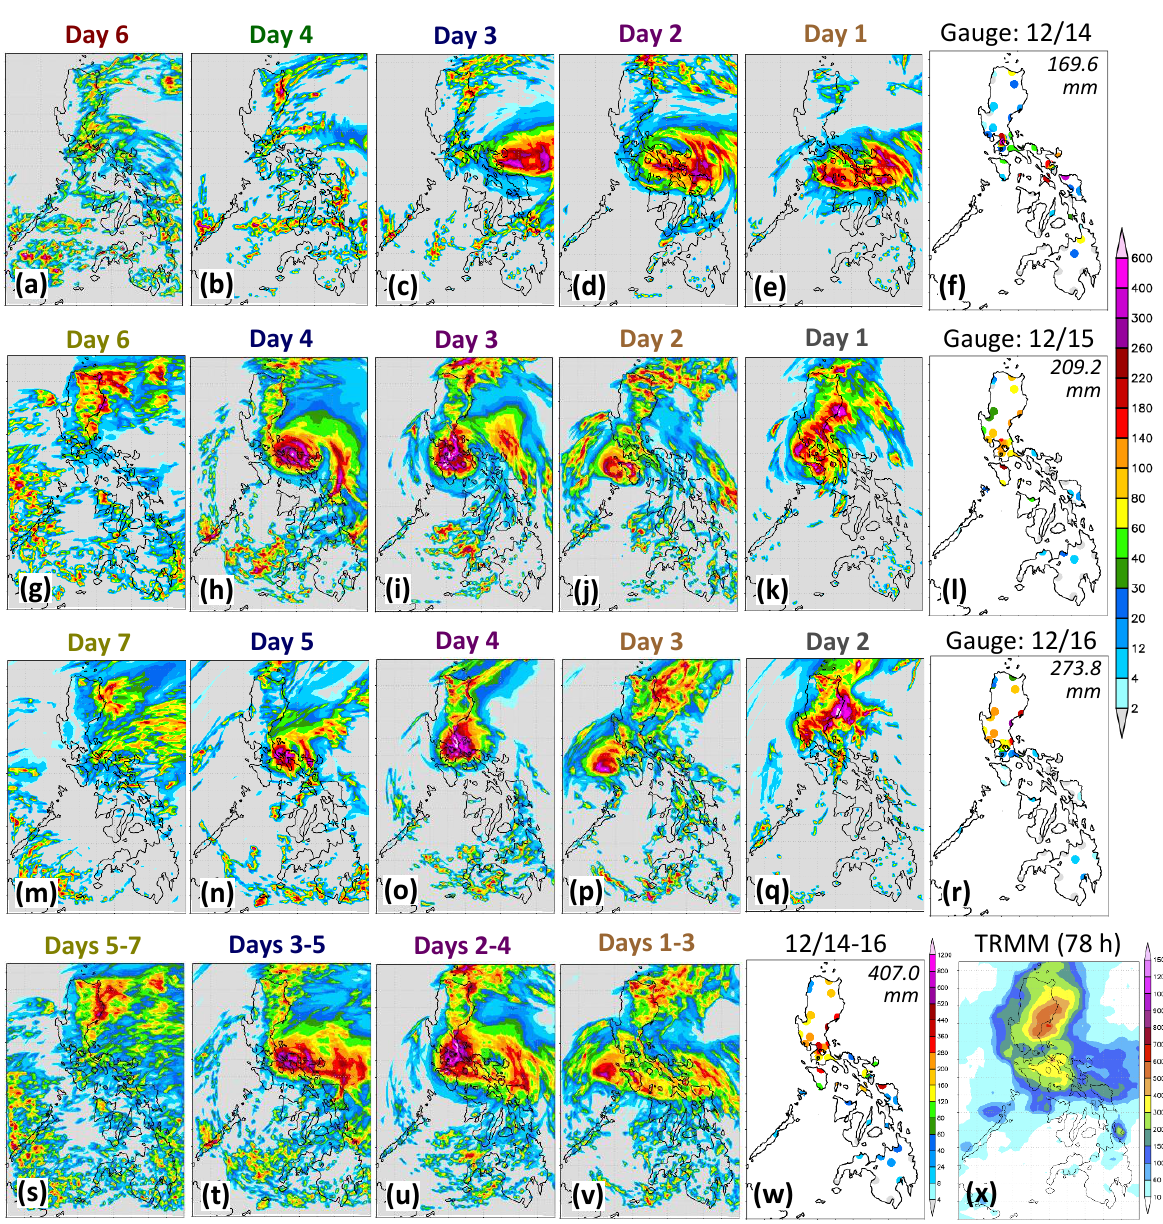
Figure 13. As in Figure 8, except for predictions (ranges as labeled) and gauge observations for the 24 h daily rainfall distributions on ( a – f ) 14, ( g – l ) 15, and ( m – r ) 16 December, respectively, ( s – w ) 72 h QPFs for 14 – 16 December 2015, and ( x ) TRMM total rainfall (mm) for the entire typhoon event (78 h starting from 1800 UTC 13 December) during TY Melor.